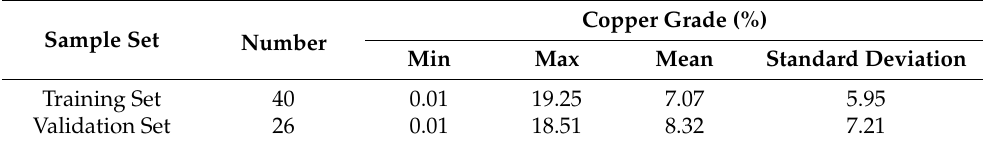
Table 2. Descriptive statistics of sample set.